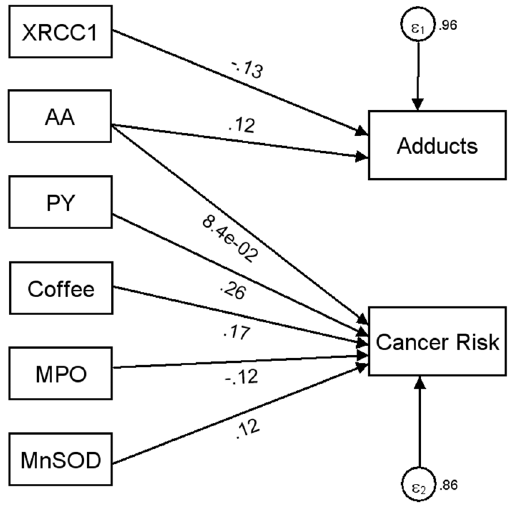
Figure 1. Path diagram of results shown in table 1. Variables (square boxes); variances (circles); causal flow (arrows); and paths (arrowed route). The estimated beta coefficients appeared along the paths. LEGEND: Packyears = Life-long consumption of cigarettes; Coffee = Life-long time-weighted average of cups/day of coffee; AA = Occupational cumulative exposure to aromatic amines; XRCC1 = X-ray repair cross-complementing protein 1; MPO = Myeloperoxidase (G- 463A homozygous variant); MnSOD = Manganese Superoxide Dis- mutase (Val/Val genotype).